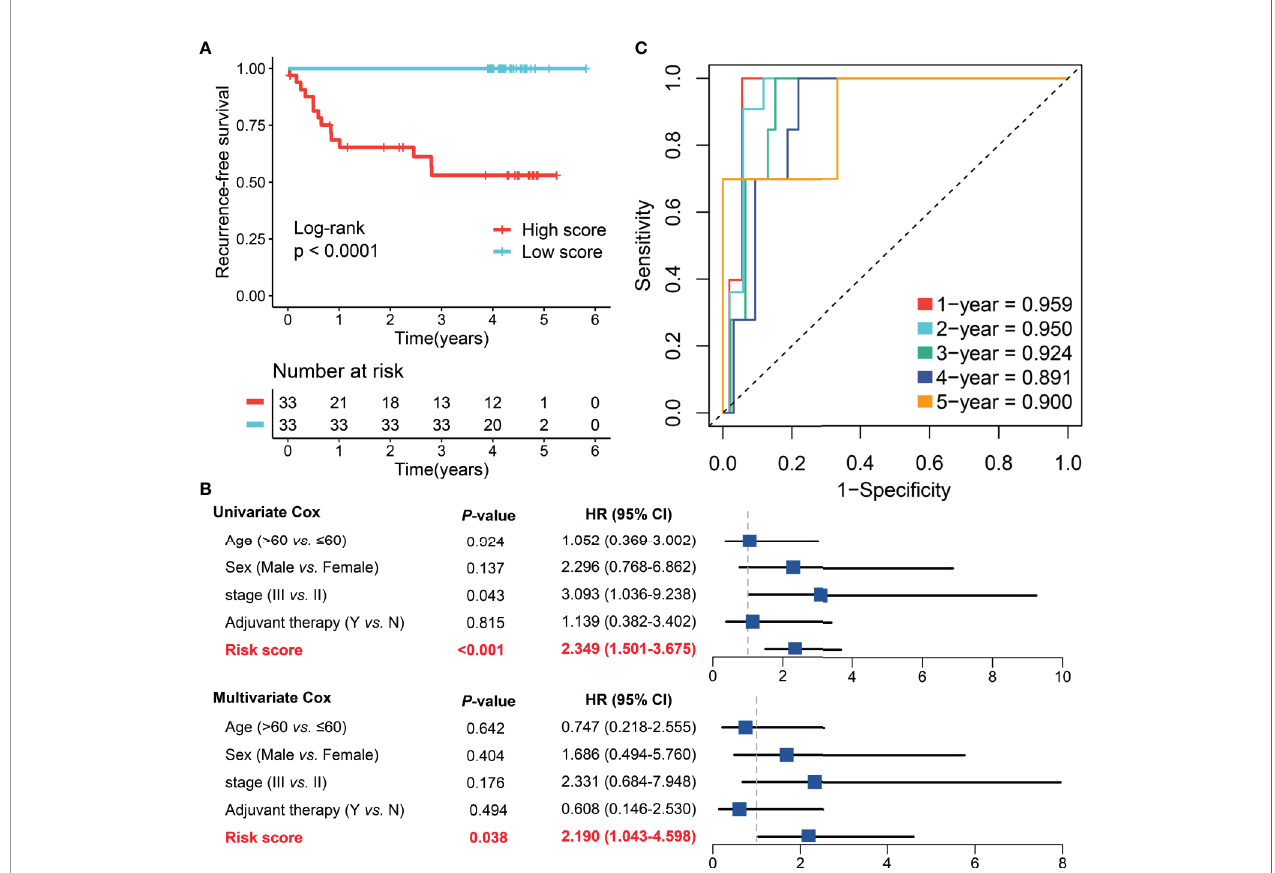
FIGURE 6 | Validation of our discovery in a clinical in-house cohort. (A) Kaplan-Meier curves of RFS according to the RAIS. (B) Univariate and multivariate Cox regression analysis of the risk score. (C) Time-dependent ROC analysis for predicting RFS at 1~5